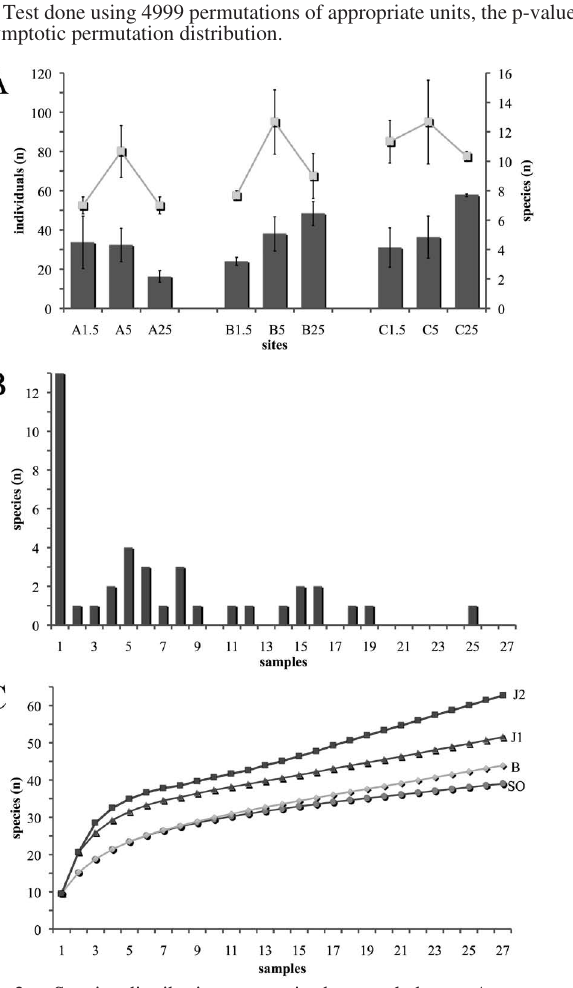
Fig . 2. – Species distribution pattern in the sampled area. A, mean number (± SE, n = 3) of syllid individuals (bars) and species (lines) at the analyzed sites. B, distribution of species according to the number of replicates occupied. C, species area accumulation curve and estimator curves (J1, Jacknife1; J2, Jacknife2; B, Bootstrap; SO, Species